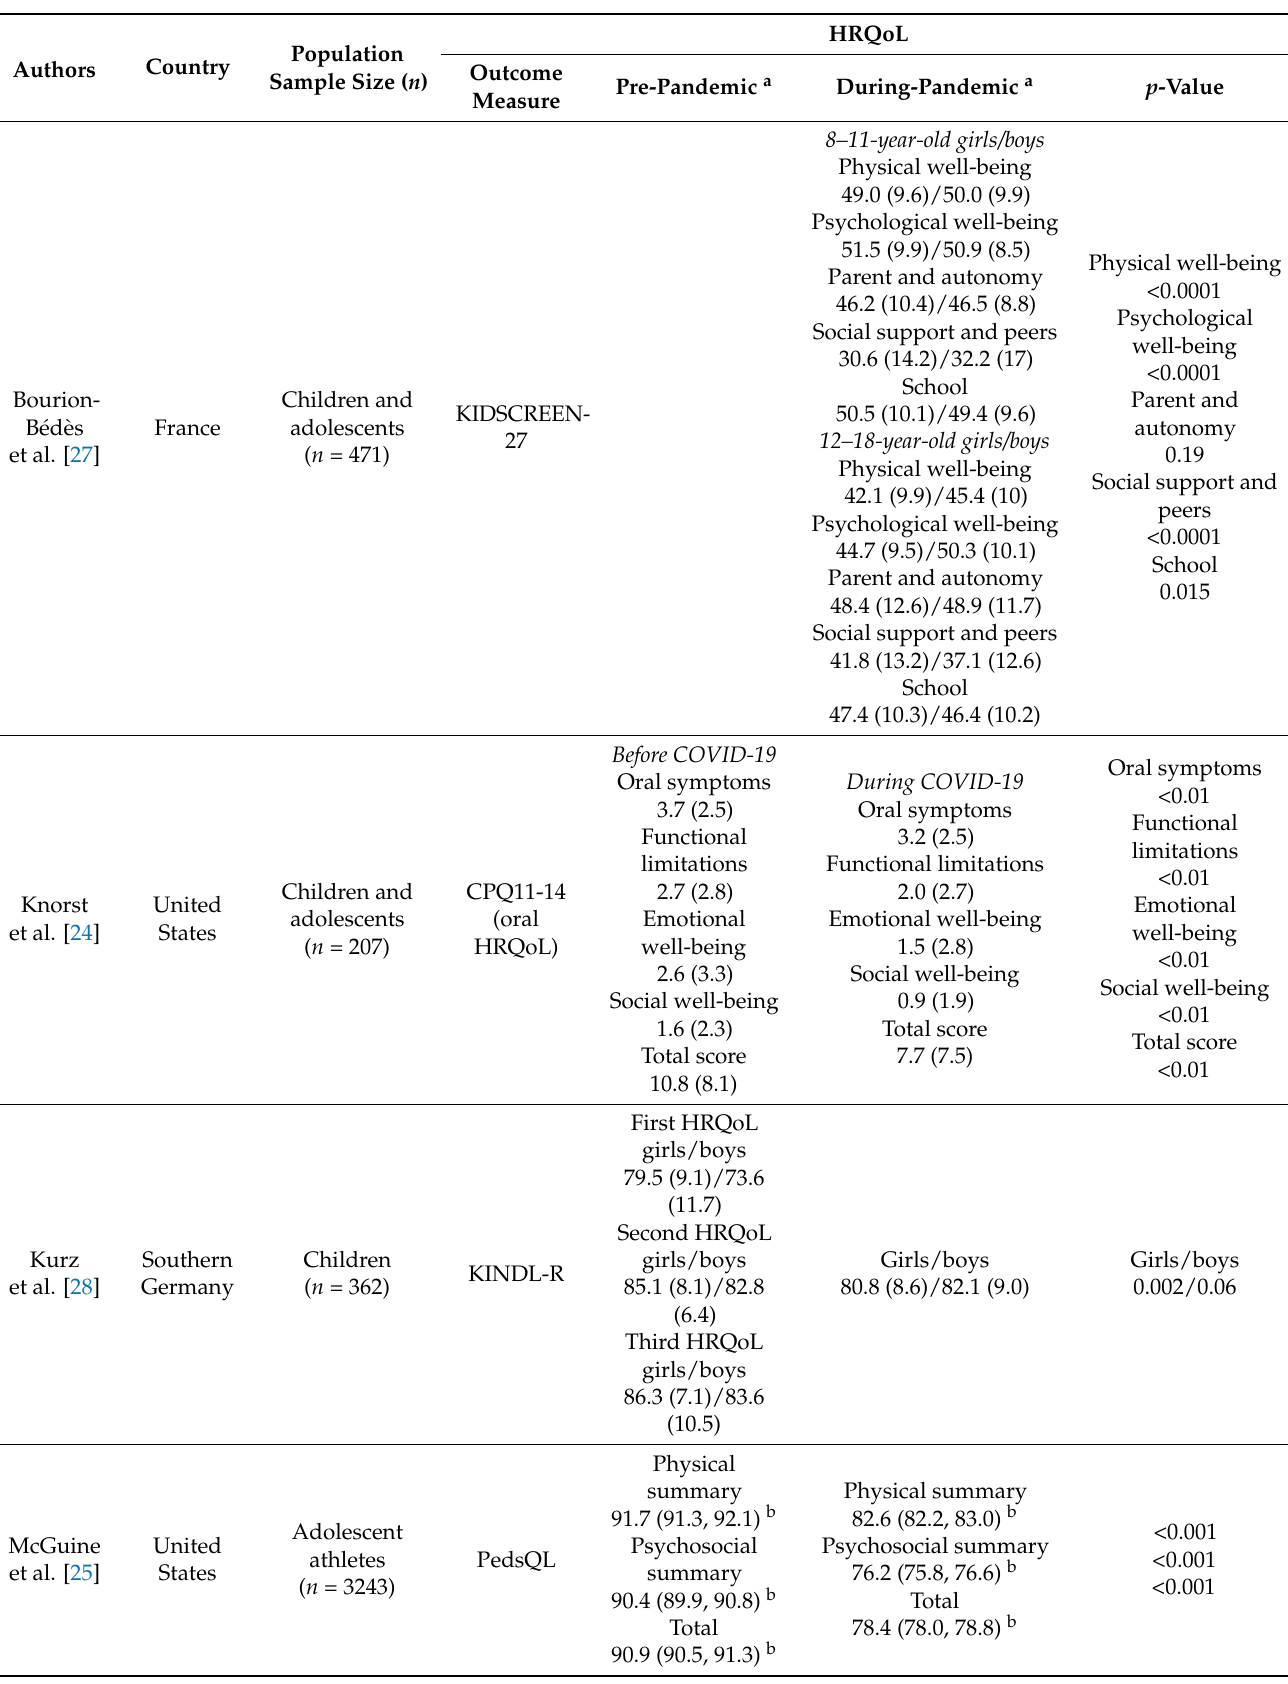
Table 3. Main findings of the HRQoL cross-sectional studies of children and adolescents during the COVID-19 pandemic ( n =